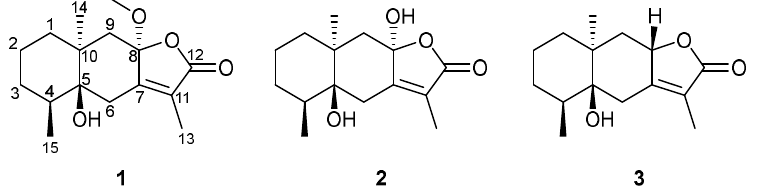
Figure 1. Structures of compounds isolated from Croton megalocarpus. Ermiasolide A ( 1 ); Ermiasolide B ( 2 ), Ermiasolide C ( 3 ).